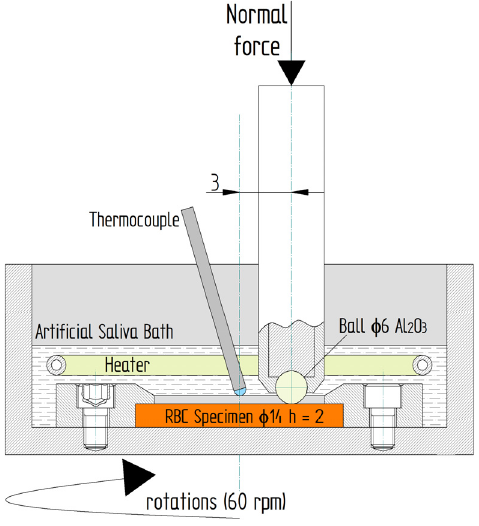
Figure 2. A schematic of the tribological test.